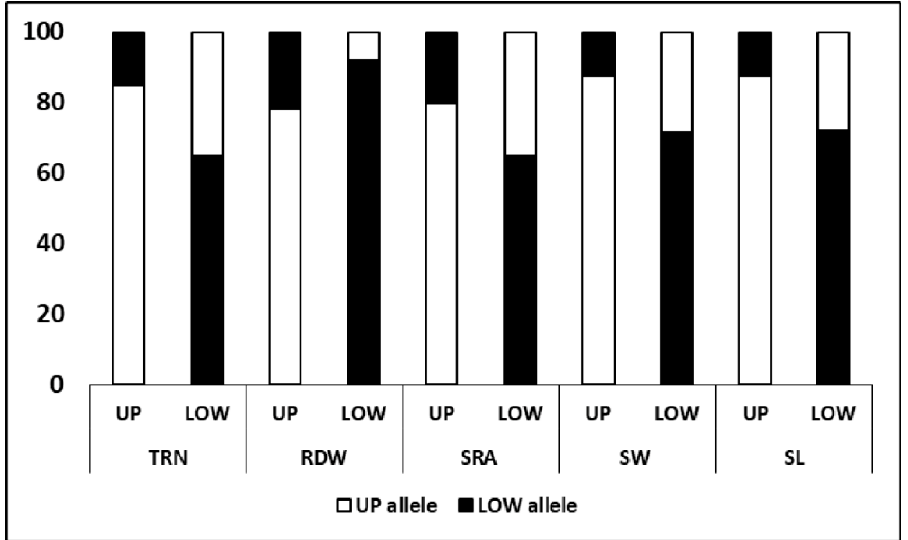
Figure 5 . Marker allele frequency means from landraces within the upper and lower 10th percentile for the analyzed traits. All significant markers shown in Table 5 are included. TRN, total root number; RDW, root dry weight; SRA, seminal root angle; SW, seed weight; SL, seed length.